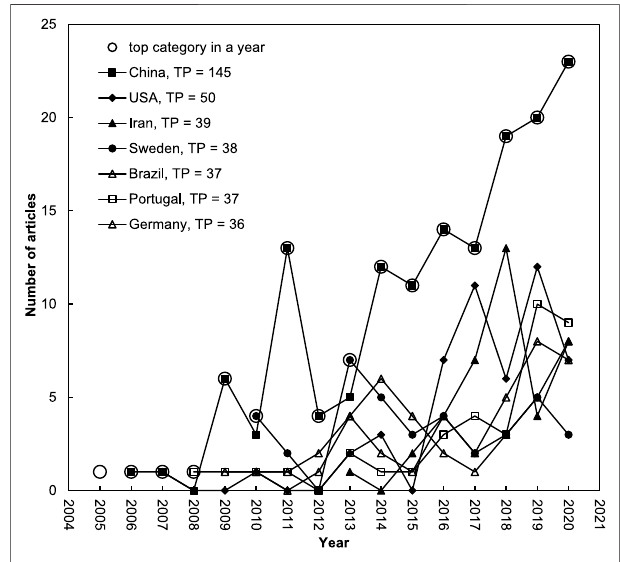
FIGURE 4 | Comparison of development trends among the top seven productive countries with TP >